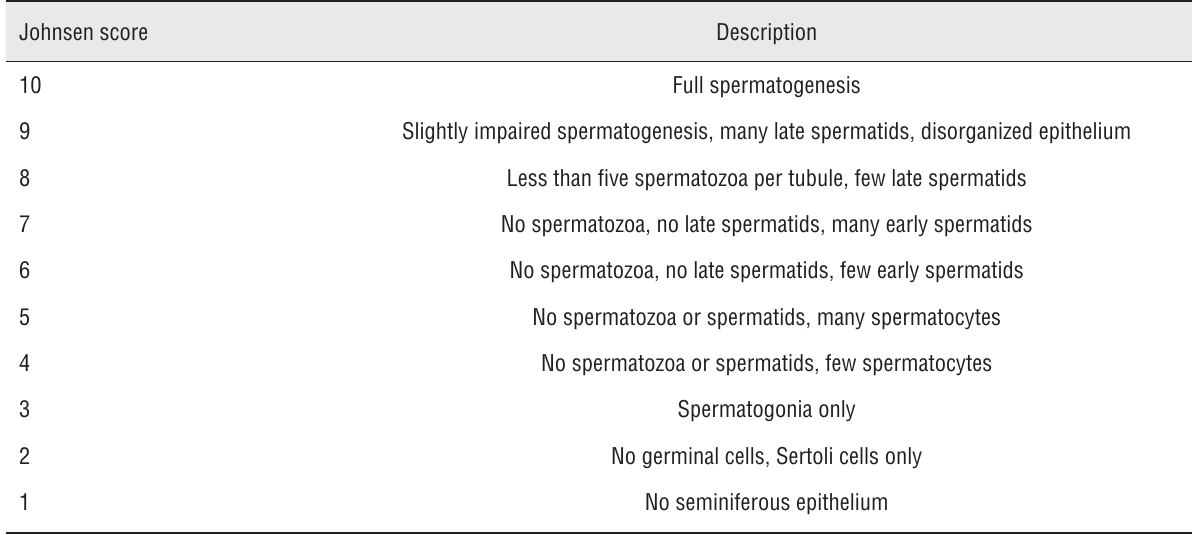
Table 1 - Modified Johnsen score